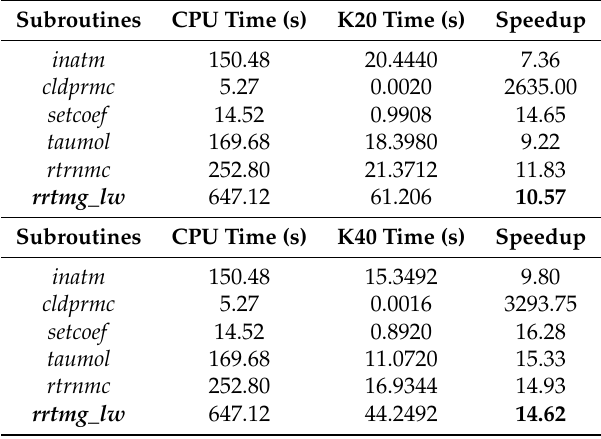
Table 2. Run-time and speedup of the 1-D G-RRTMG_LW on one GPU, where the block size = 16 and ncol =